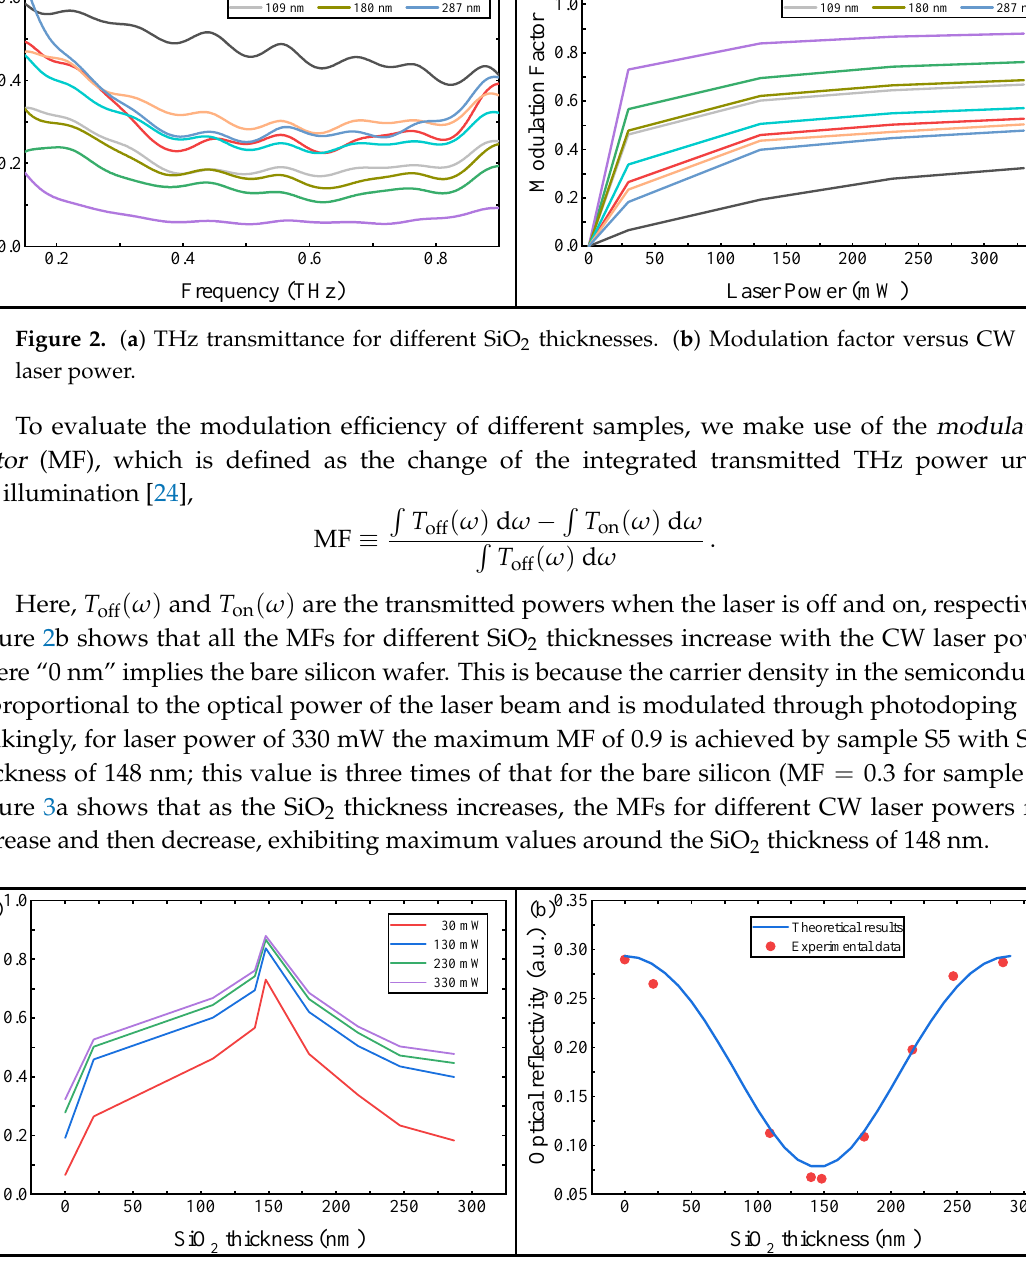
Figure 3. ( a ) THz modulation factor versus SiO 2 thickness under the illumination of different CW laser powers. ( b ) Calculated (blue curve) and measured (red dots) optical reflectivity of the CW laser versus SiO 2